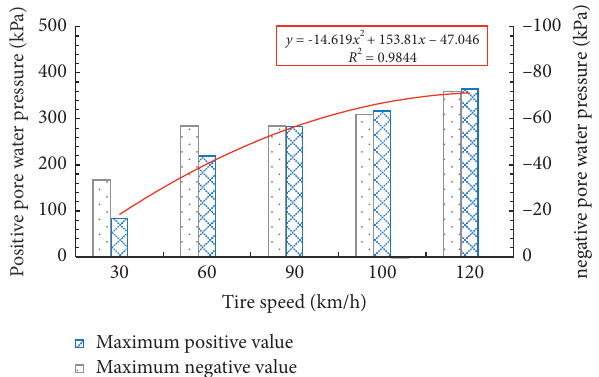
Figure 13: Maximum hydrodynamic pressure at different tire speeds.